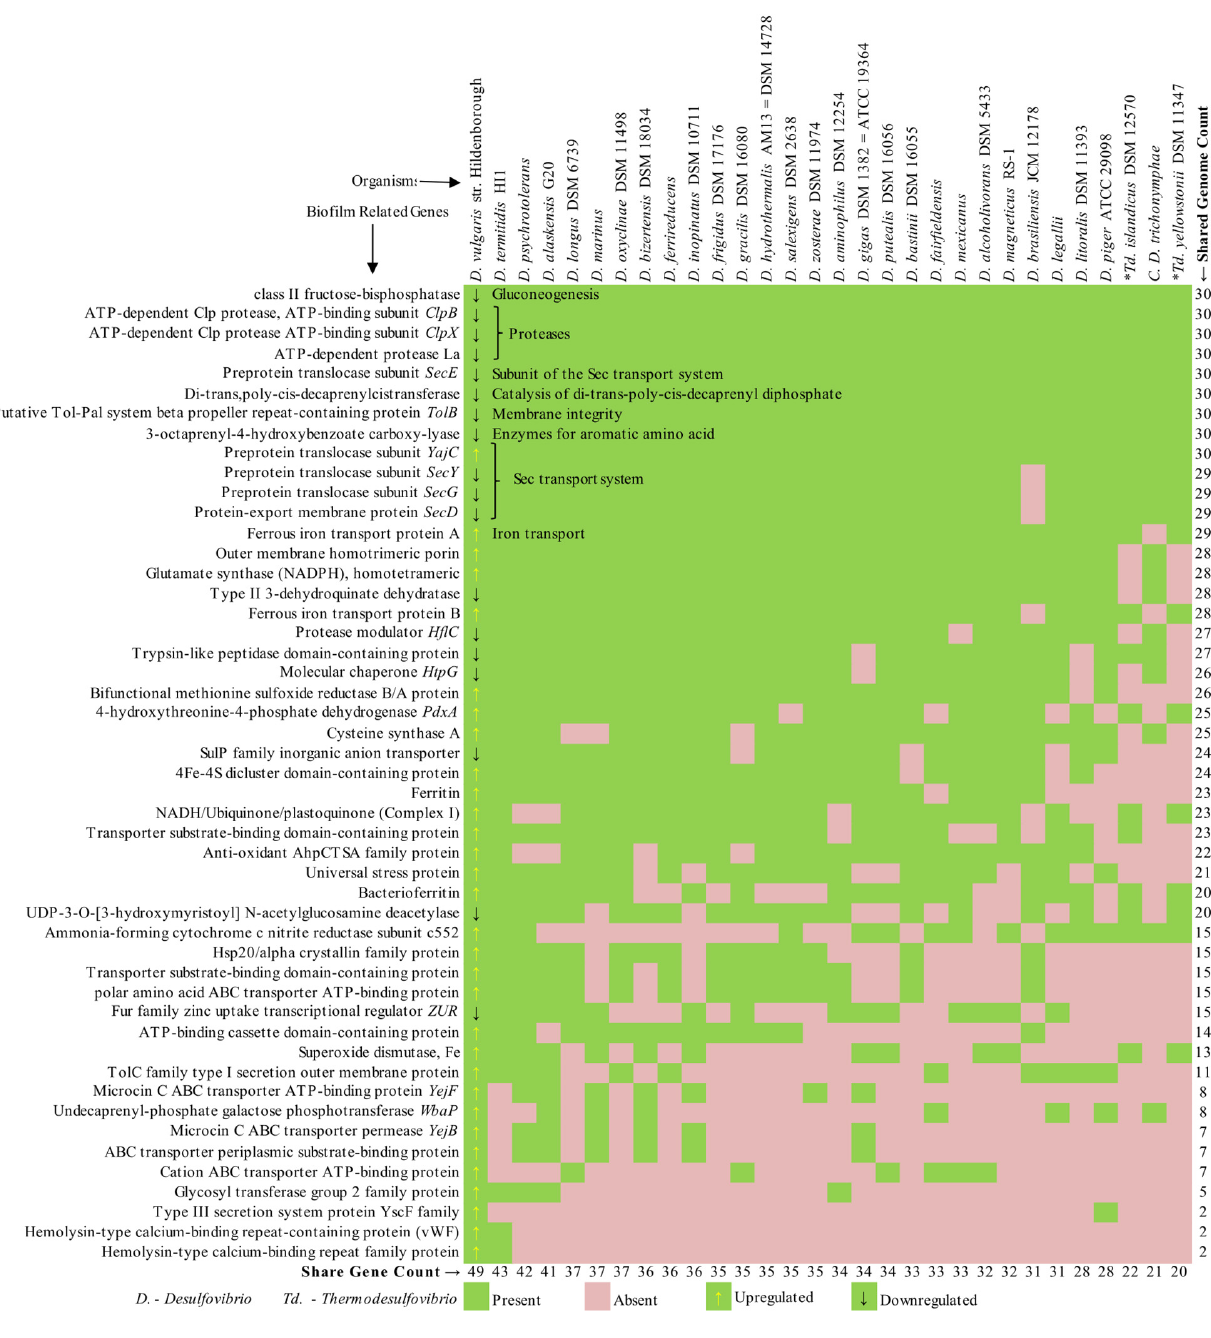
FIGURE 2 | Presence–absence matrix of biofilm genes shared across 30 sulfate-reducing bacteria (SRB)